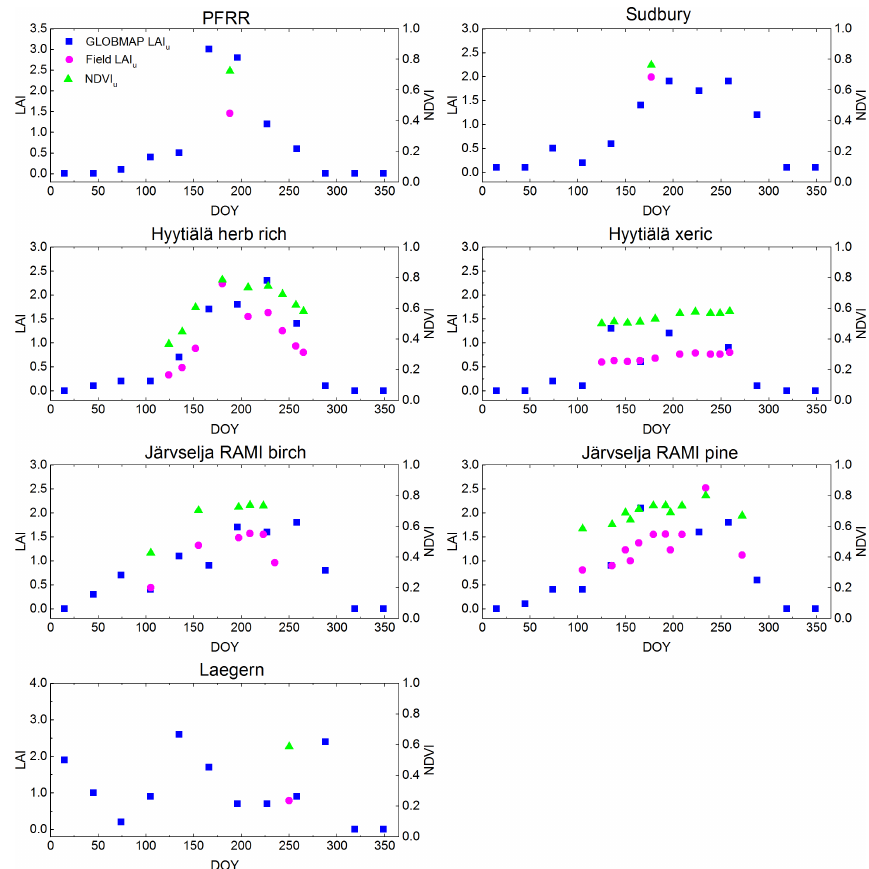
Figure 10. Seasonal profiles of GLOBMAP LAI u (blue) values and their comparison with in situ understory NDVI (NDVI u , green) measure- ments and estimated understory LAI from field NDVI u (field LAI u , pink) in seven forest sites, including stands in PFRR, Sudbury,